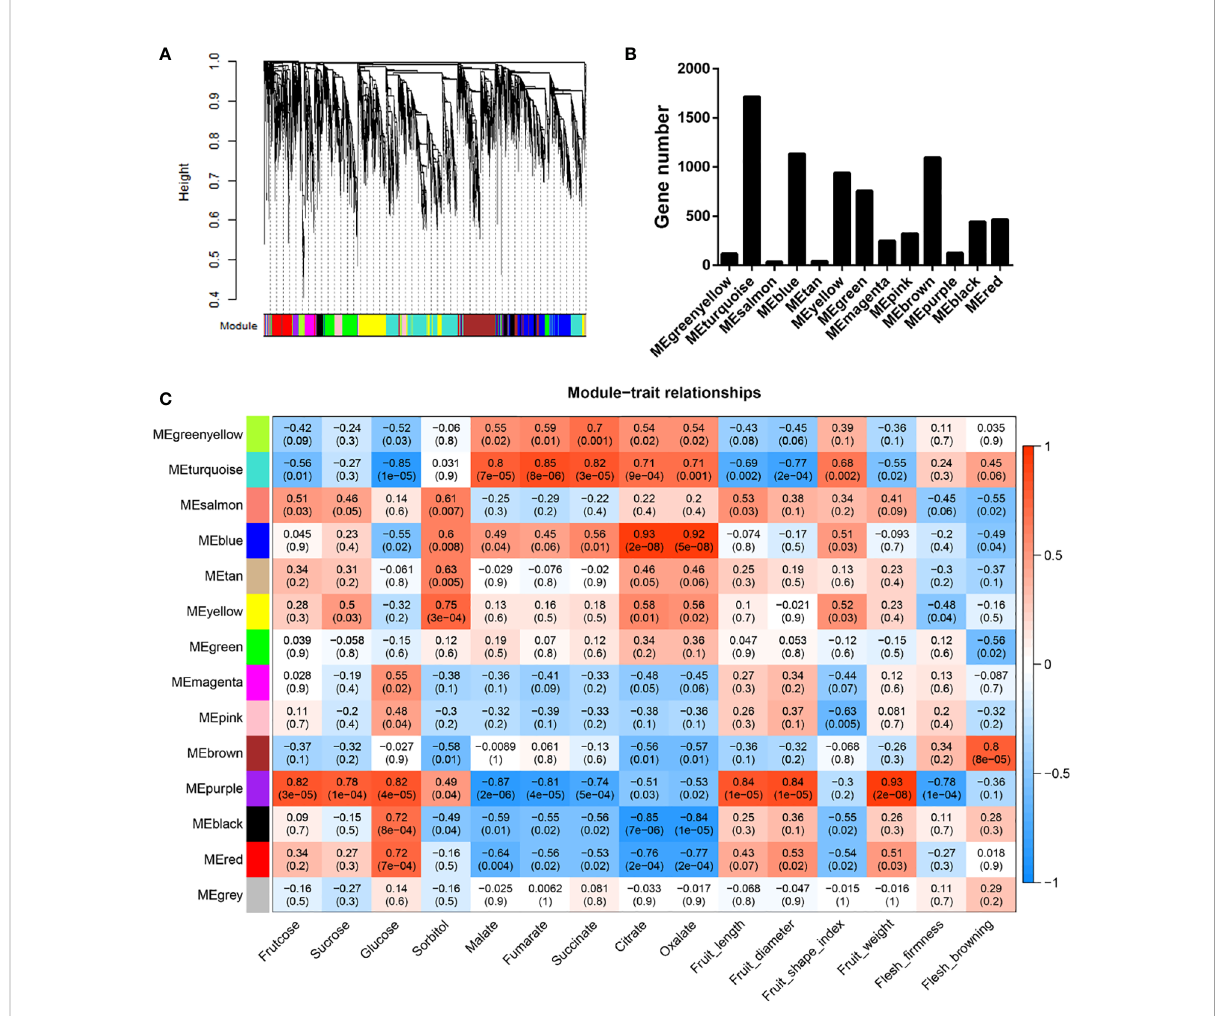
FIGURE 5 Weighted gene co-expression network analysis of differentially expressed genes between ‘ HanFu ’ and ‘ Huahong ’ over three development stages. (A) A clustering dendrogram of the differentially expressed genes (DEGs), with dissimilarity based on topological overlap, together with assigned module colors. (B) The numbers of genes harbored in each module. (C) Module-trait associations. Each row corresponds to a module eigengene, and each column to a trait. Each cell contains the corresponding correlation and P values. The table is color coded by correlation as indicated in the color